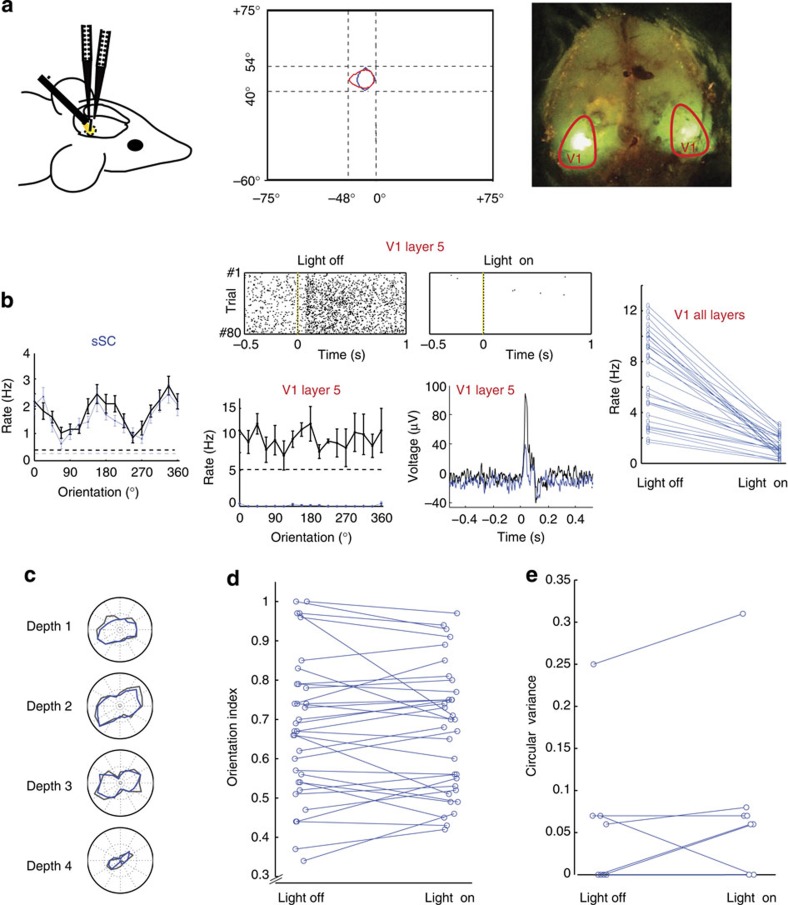
Vertical grouping of orientation is independent of visual cortex.(a) Two recording probes are placed in matching retinotopic positions in V1 and the sSC, whereas a LED-coupled fibre was placed above V1. The middle panel shows the ON-response fields for one V1 site (red) and sSC site (blue) during a simultaneous recording. The right panel is an example of expression by viral transfection imaged by fluorescent microscope. The red lines indicate the estimated outline of V1 based on stereotactic coordinates. (b) Responses of multi-units in sSC and layer 5 of binocular V1 in the injected area of an example experiment (left and middle-down left) and visual evoked potential in layer 5 of V1 (middle-down right) during light-off condition (black) and light-on conditions (blue) show that V1 L5 is silenced, while sSC remains active. Error bars in tuning curves are mean±s.e.m. Time 0 s is the onset of the visual stimulus. The light was turned on 1 s before this. The middle-top panel is the corresponding raster plot of spikes in V1 L5 when the light is off (left) and on (right). The right panel shows the effect of shining light on silencing all layers of V1 of 6 mice (n=29). (c) Example tuning curves from four depths in the sSC, separated by 50 μm, with V1 active (black) and silenced (blue). (d) Orientation tuning of units with V1 active (left) and silenced (right) is not changed (P=0.99, Wilcoxon signed rank sum test, n=33, 6 mice). (e) Circular variances of eight vertical penetrations in the sSC in light off (V1 active) and light on (V1 silenced) conditions is not significantly changed (P=0.31, Wilcoxon signed rank sum test, 6 mice).